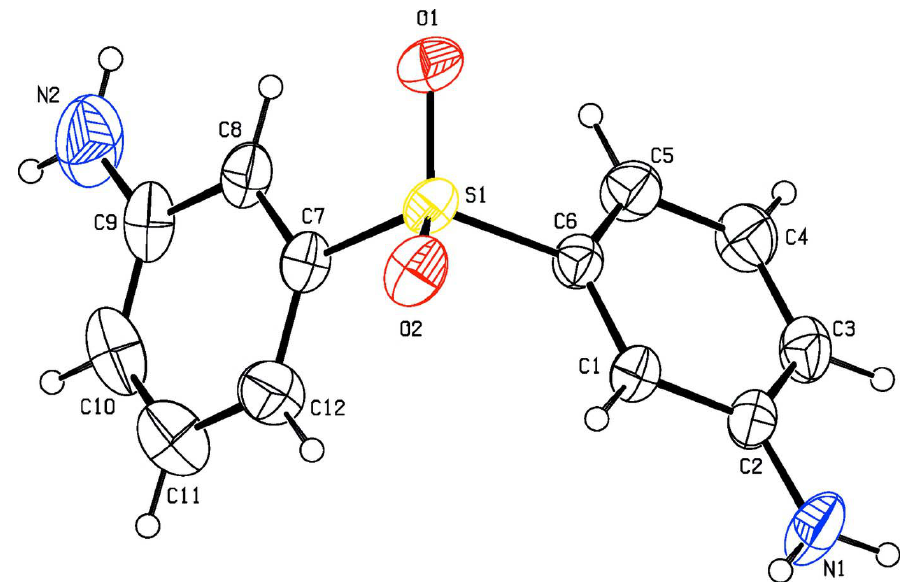
Figure 1 The molecular structure of the title molecule, with the atom-numbering scheme. Displacement ellipsoids are drawn at the 30% probability level.